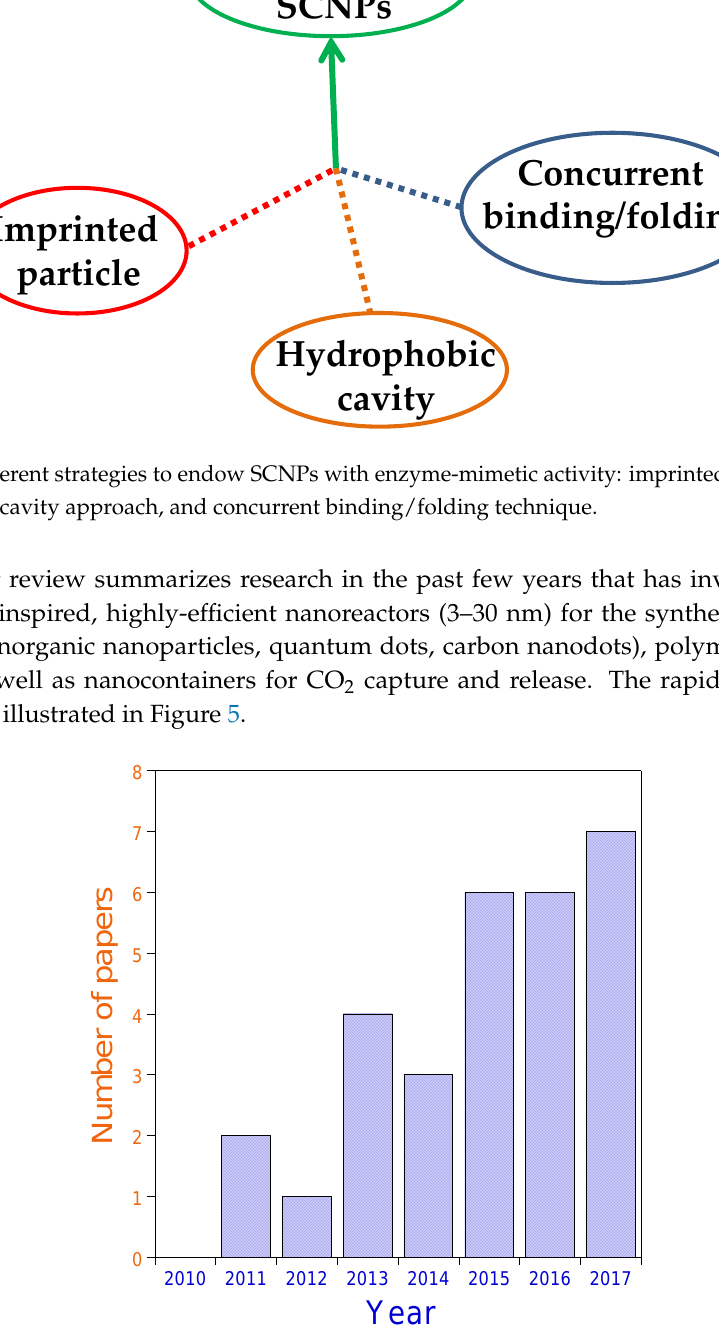
Figure 5. Evolution of the field of SCNPs for catalysis applications over recent years (2011–2017). Data for 2017 include only papers published until August.